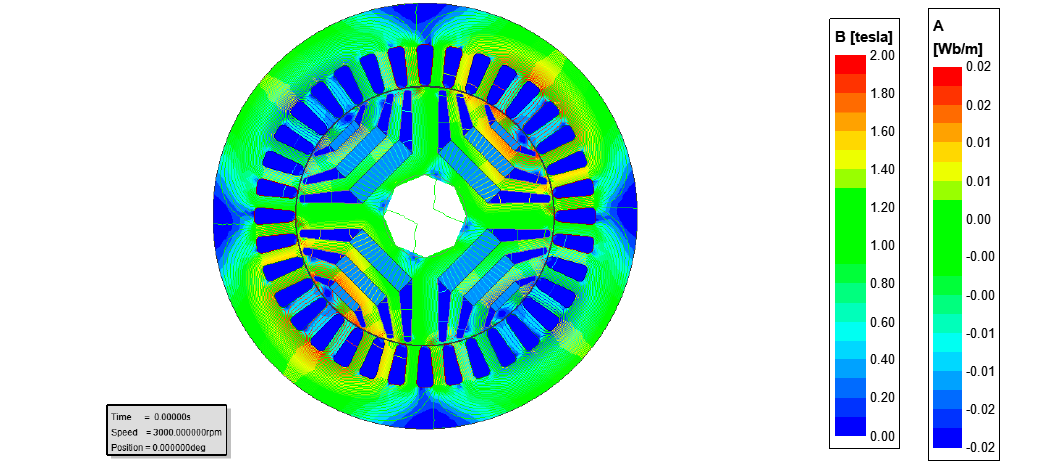
Figure 5. Flux distribution plot of the FMSynRM.